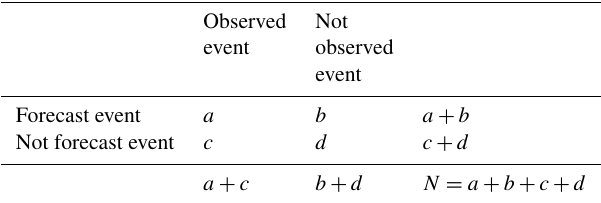
Table A1. Contingency table for a binary event. The table fully de- scribes the joint distribution of forecast and observation for N fore- cast/observation